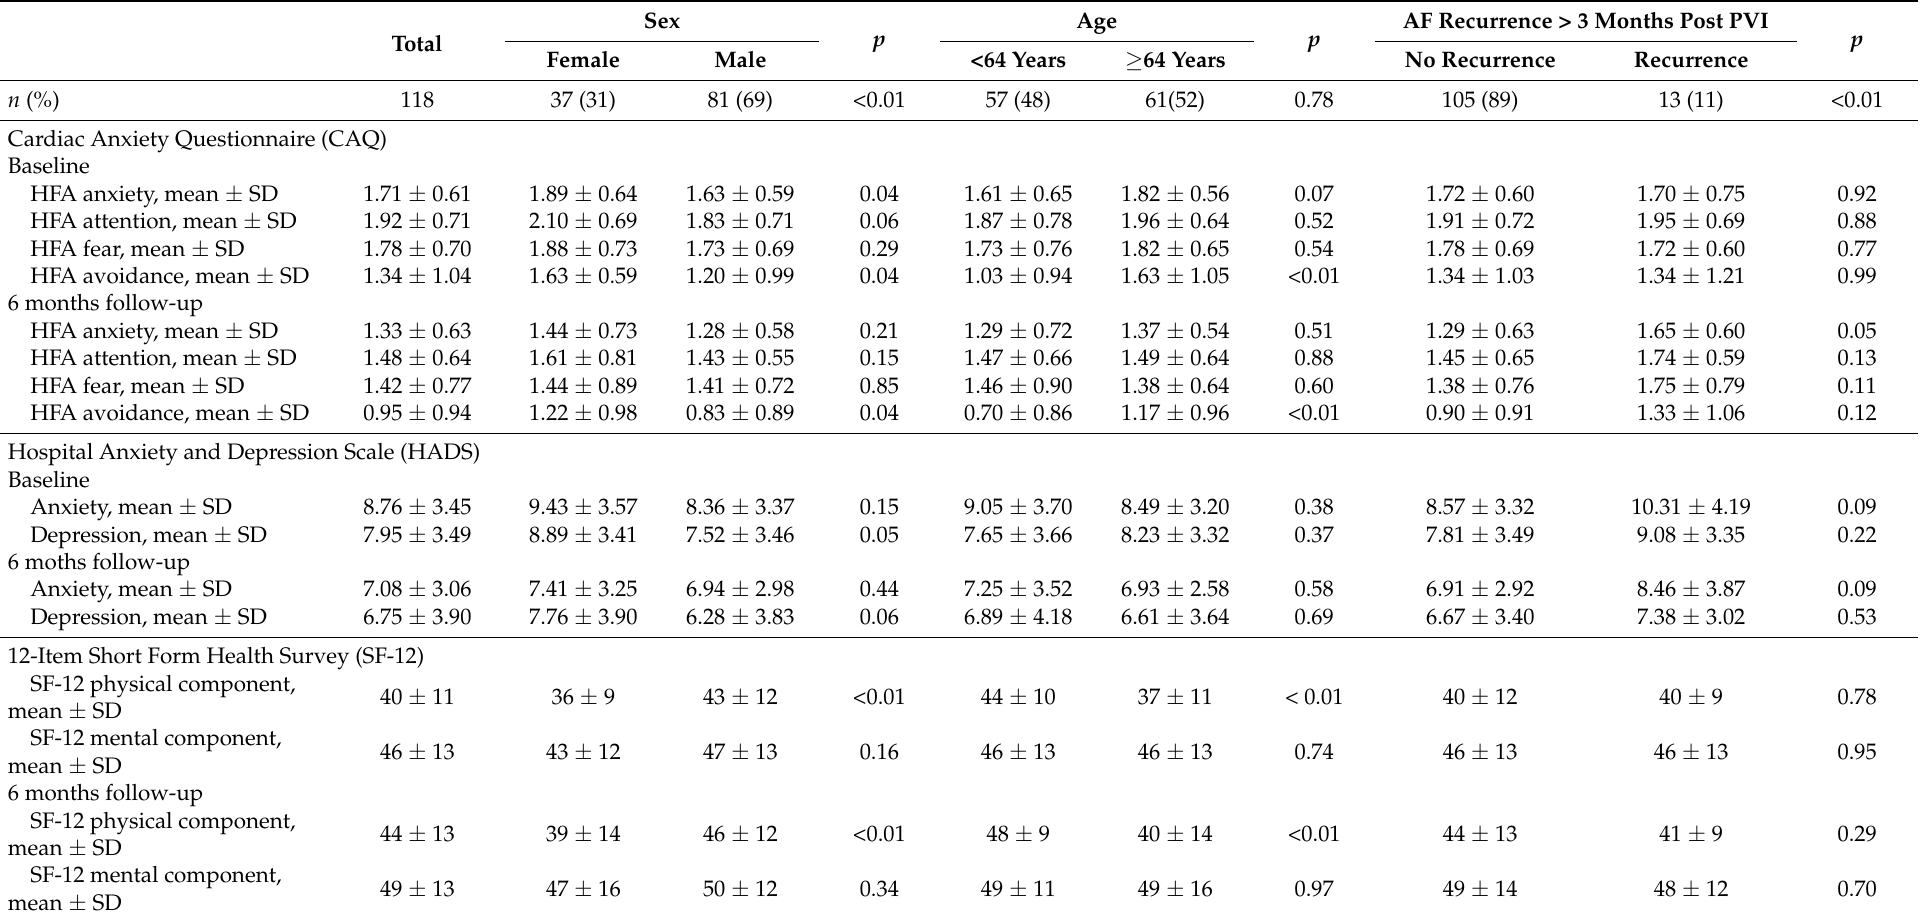
Table 2. Psychological measures at baseline and 6 months